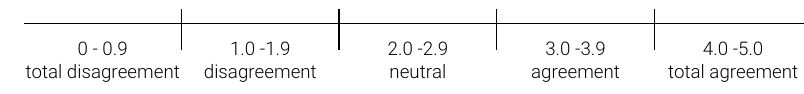
Figure1. Rating of acceptability to determine students`